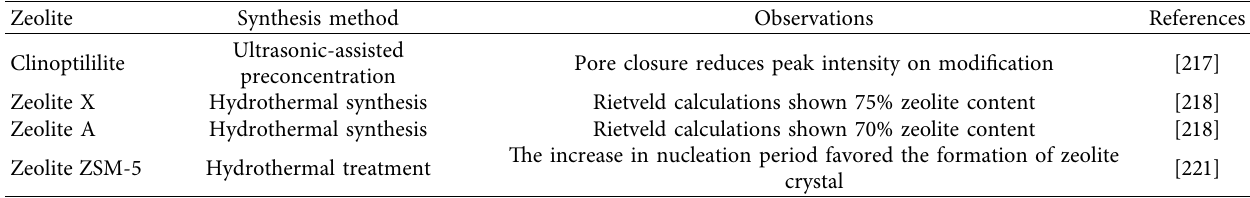
Table 6: Summary of the XRD analysis of zeolites.